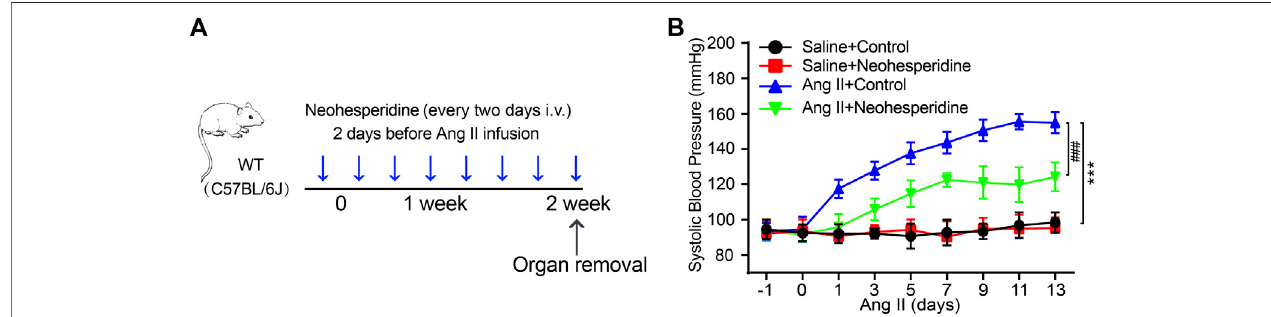
FIGURE 1 | Neohesperidin inhibits hypertension induced by Ang II in mice. Mice were infused with Ang II (490 ng/kg/min) by Alzetmodel 1,002 micropump for 2 weeks. A caudal vein injection of Neohesperidin (50 mg/kg/day) was performed for 16 days (A) Schematic diagram of the whole process of the experiment; (B) An average systolic blood pressure of each group ( n = 6). Statistical analysis was performed with one-way ANOVA. *** p < 0.001, sham vs. Ang II; ### p < 0.001, Ang II vs. Ang II + Neohesperidin.